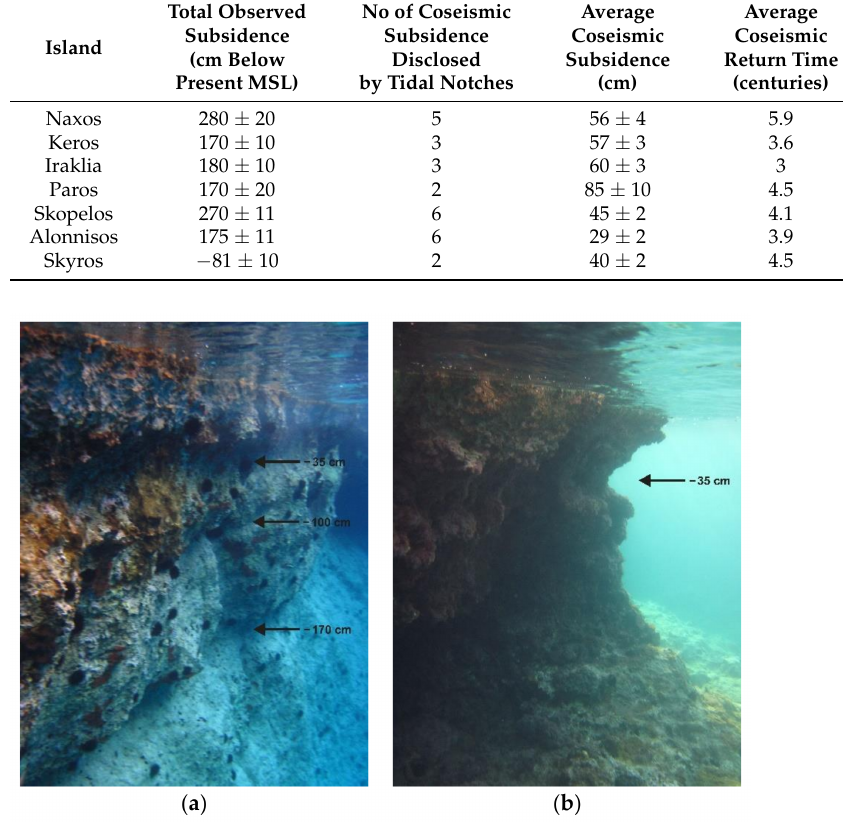
Figure 3. ( a ) Multiple submerged tidal notches at Keros Island at − 35 cm, − 100 cm and − 170 cm. ( b ) The upper tidal notch at Paros Island is about − 35